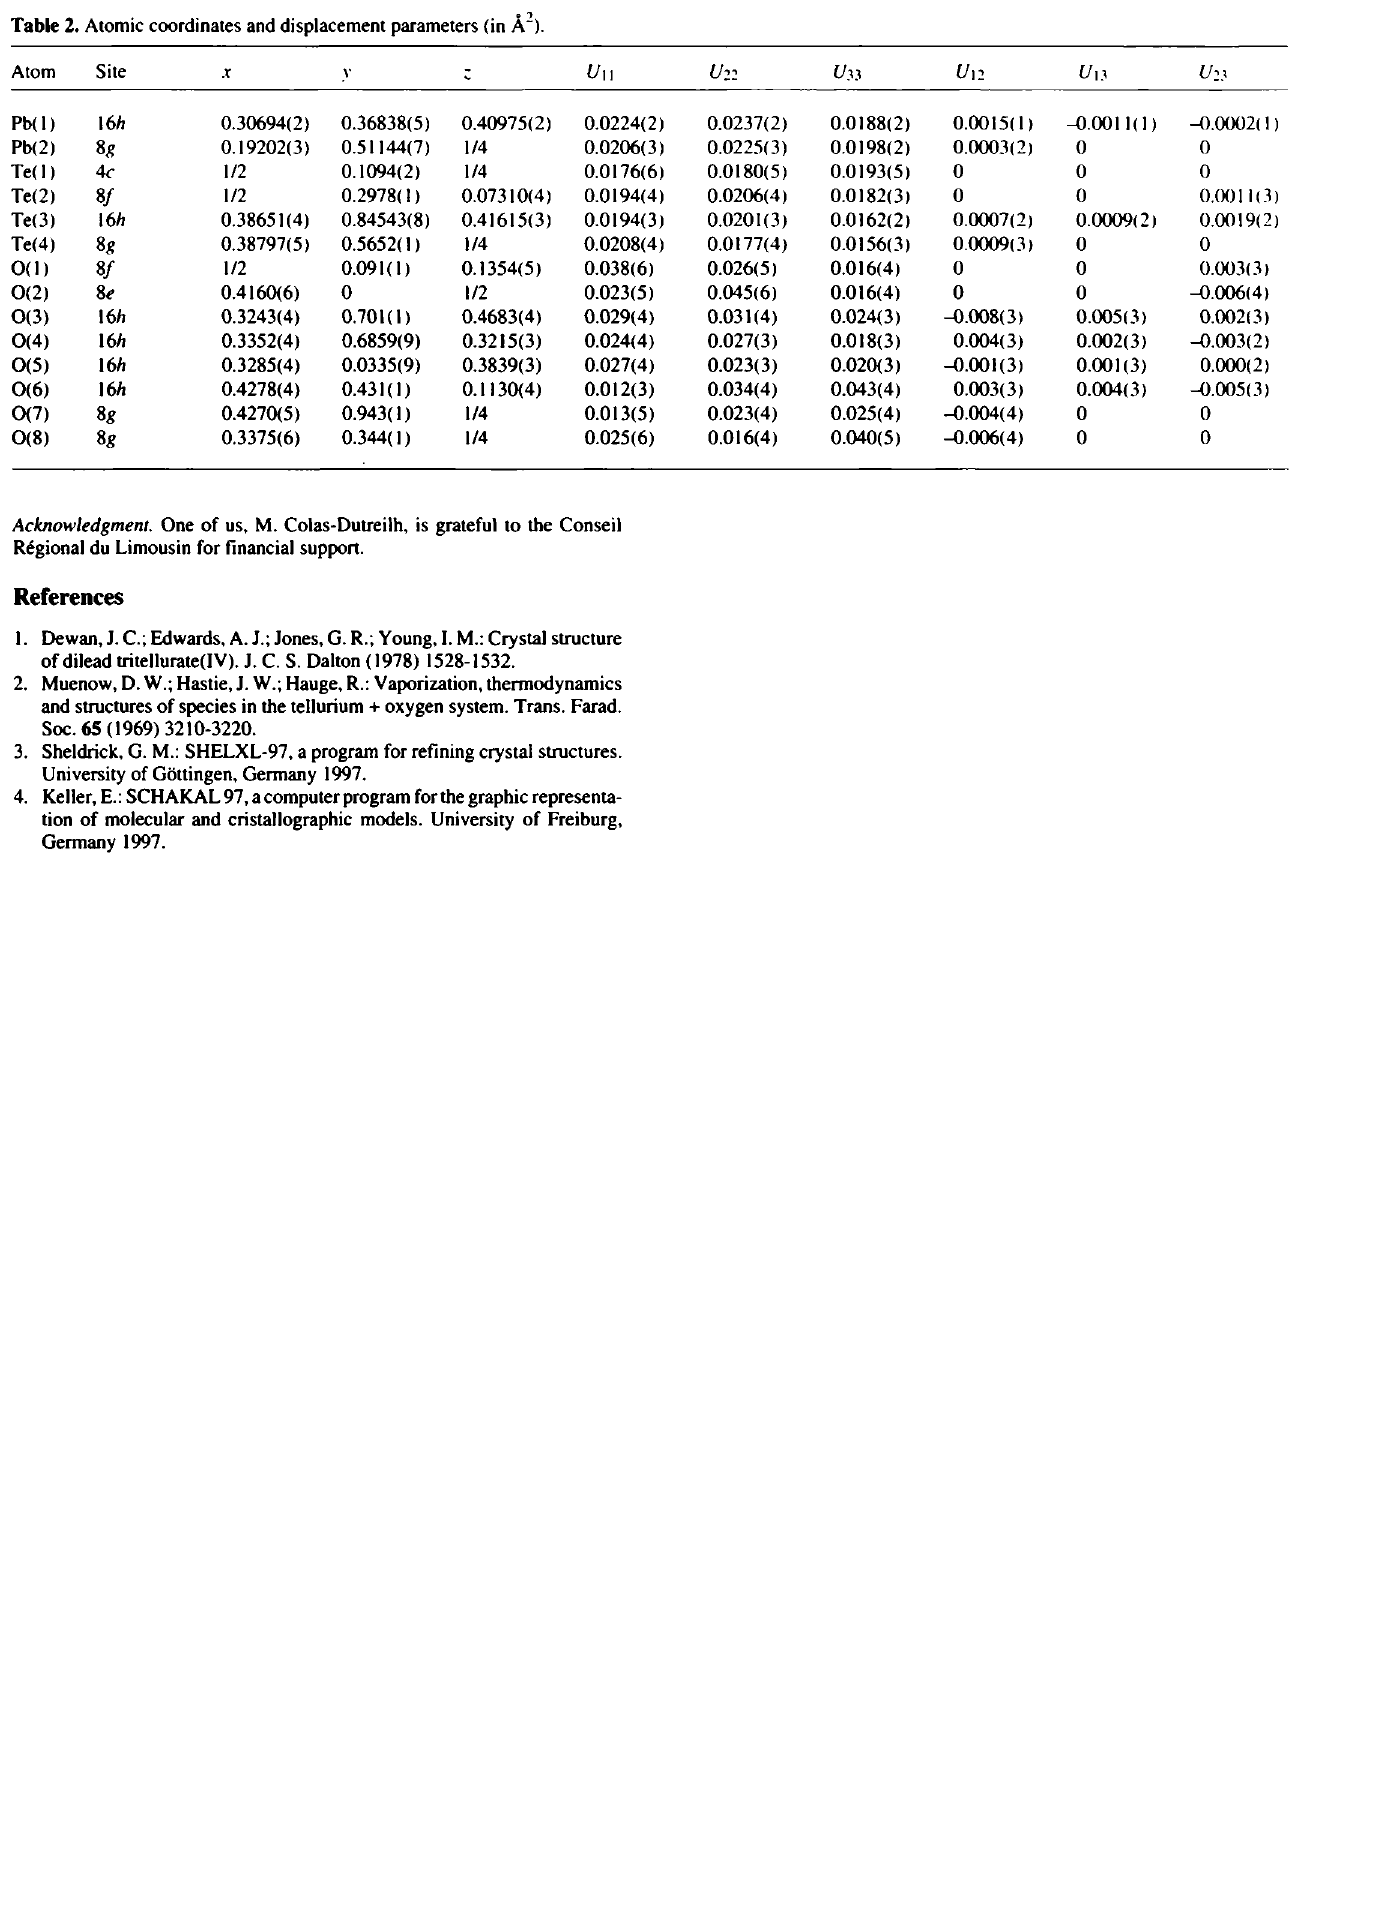
Table 2. Atomic coordinates and displacement parameters (in A 2